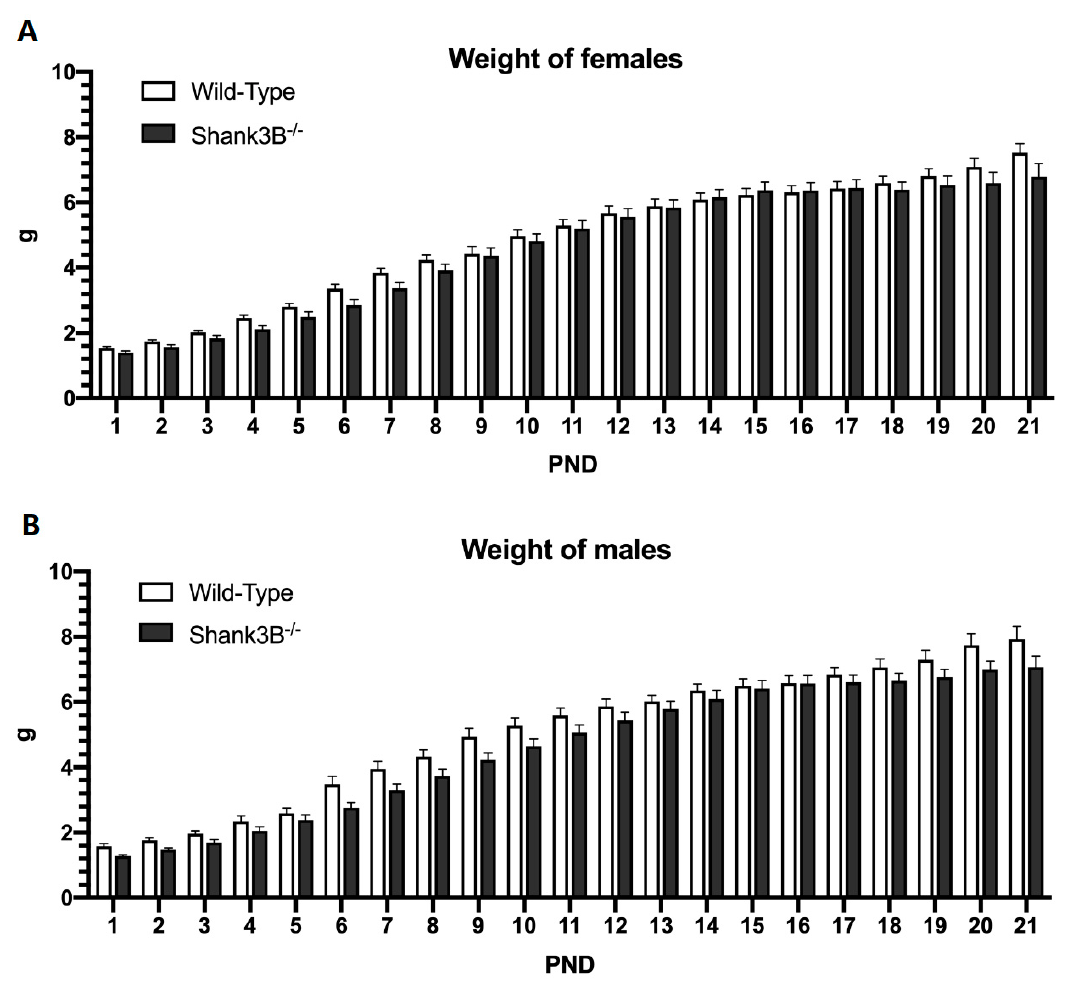
Figure 2. Body weight: ( A ) Females and ( B ) males from PND = 1 to PND = 21. PND = postnatal day; Data are shown as mean + SEM. Shank3B − / − : ♀ n = 13, ♂ n = 10; Wild-Types: ♀ n = 29, ♂ n = 15.